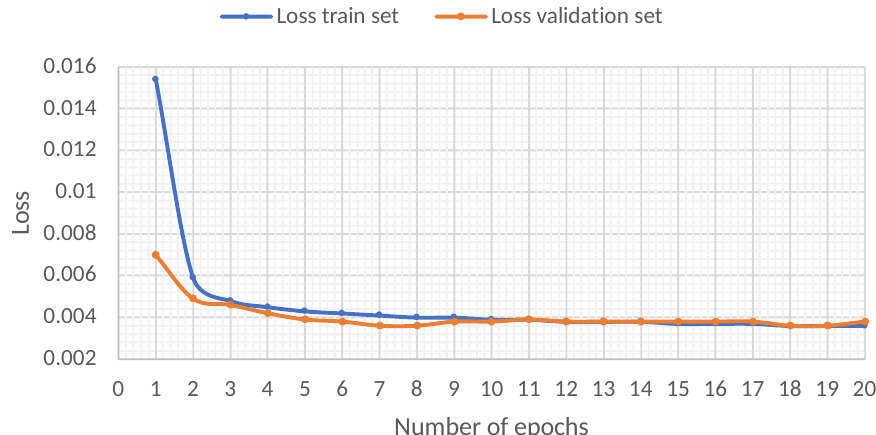
Figure 9. Evaluation of the loss behavior of the GRU model through the epochs in the train set and test set.